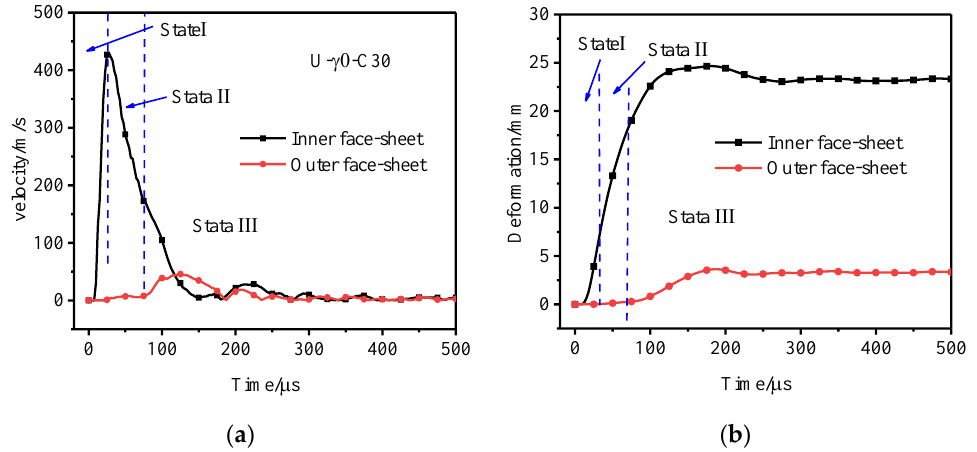
Figure 9. Deformation process of the aluminum foam sandwich tube. ( a ) Velocity – time curve of inner and outer tubes, and ( b ) deformation curve of inner and outer tubes.